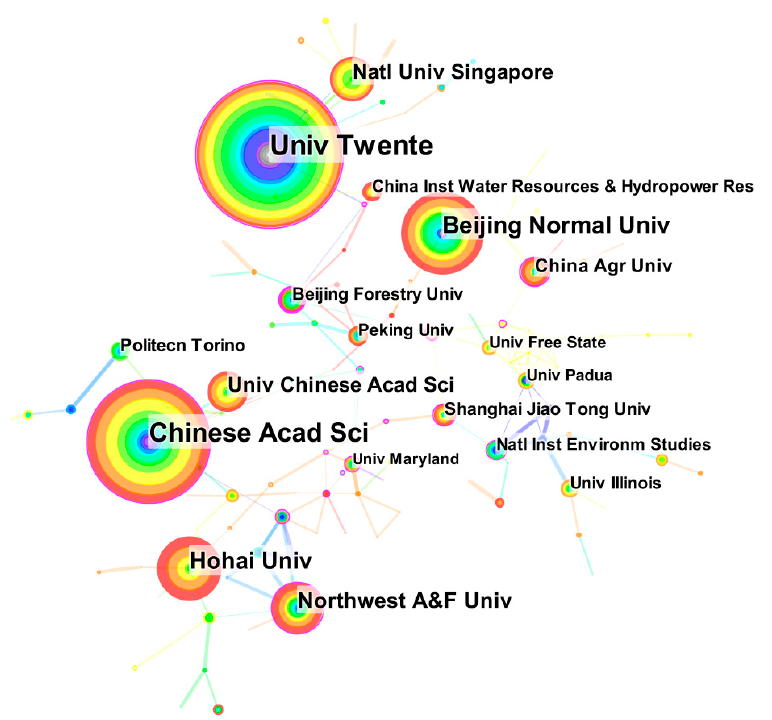
Figure 4. Cooperative network among institutions.